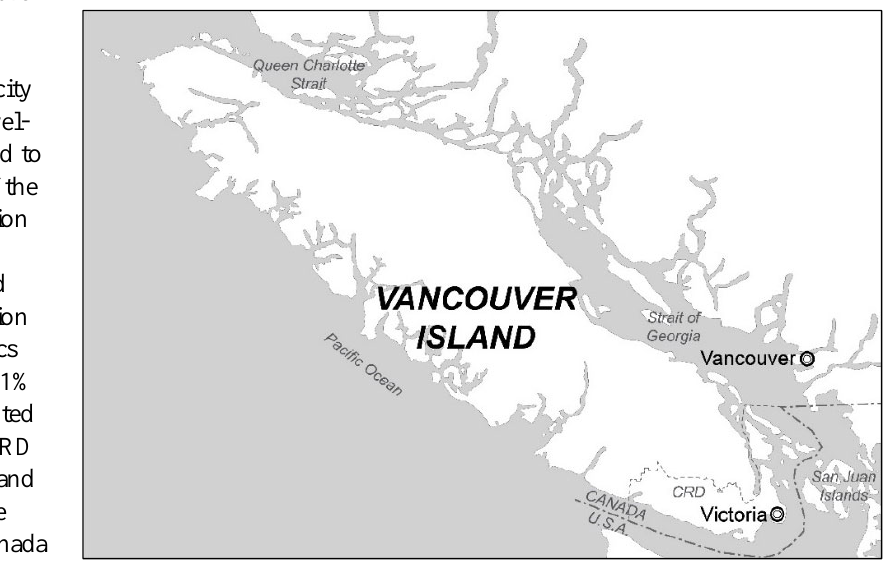
Figure 1. Map of Vancouver Island Showing the Location of Victoria and the Capital Regional District